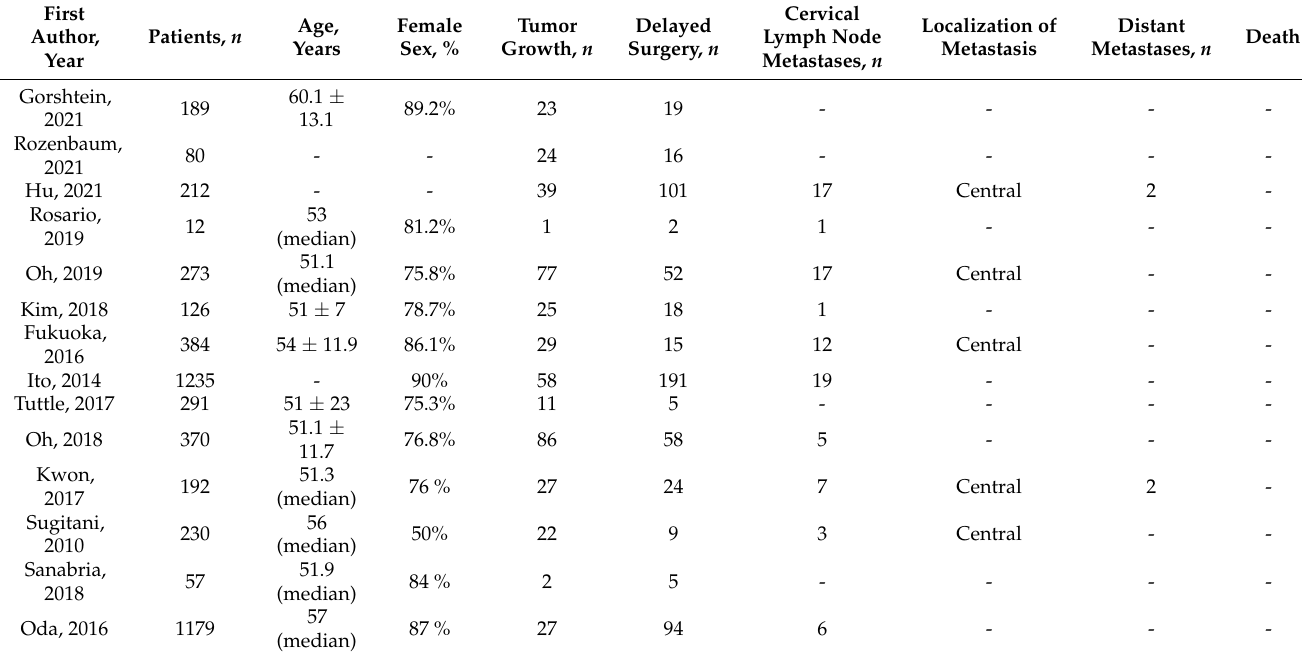
Table 2. Characteristics of included